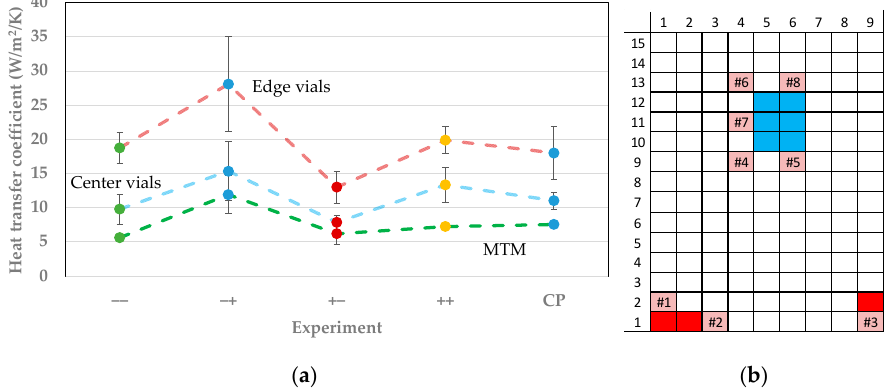
Figure 3. ( a ) Vial heat transfer coefficients for edge (red dotted line) and center (blue dotted line) vials and MTM (green dotted line) for different process conditions. ( b ) Vial and WTMplus position (pink with corresponding number) and vial category (red: edge vial; blue: center vial).